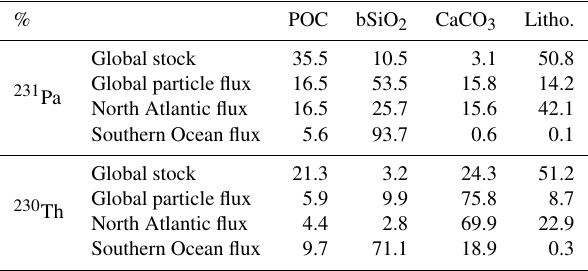
Table 4. Relative global budget of 231 Pa and 230 Th in the different particulate phases (“global stock”) in percentages. Globally aver- aged fluxes in the different phases (“global particle flx”), and the same but for the North Atlantic Ocean (44–24 ◦ W, 25–56 ◦ N) and the Weddell Sea (44–24 ◦ W, 76–63 ◦ S), all in percentages associ- ated with each particle